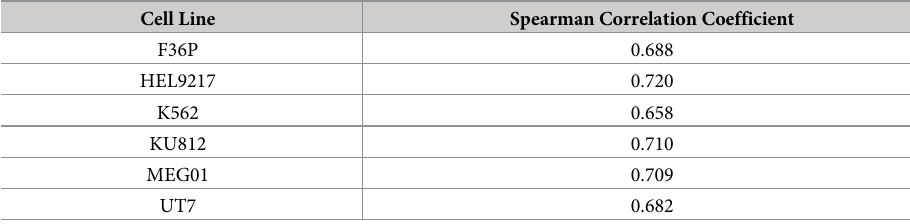
Table 1. Comparison of cell line gene expression to